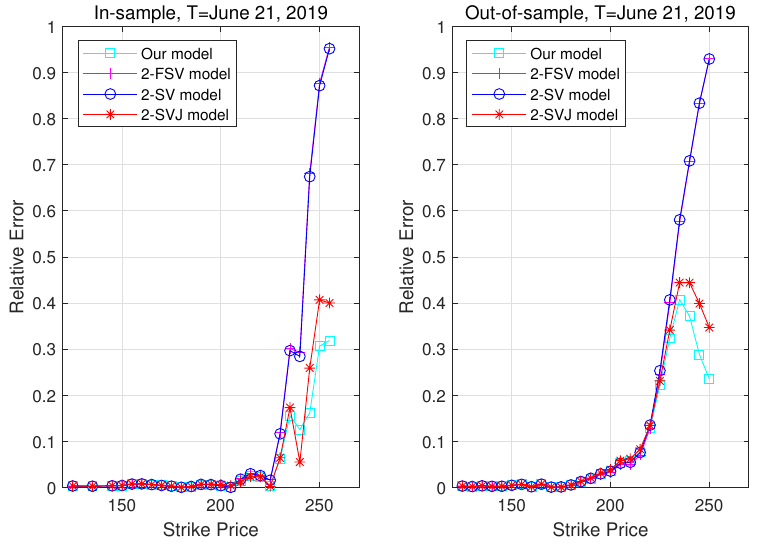
Figure 5. The comparison of predicted prices of four model specifications and market prices on 9 May 2019, with maturity T = 21 June